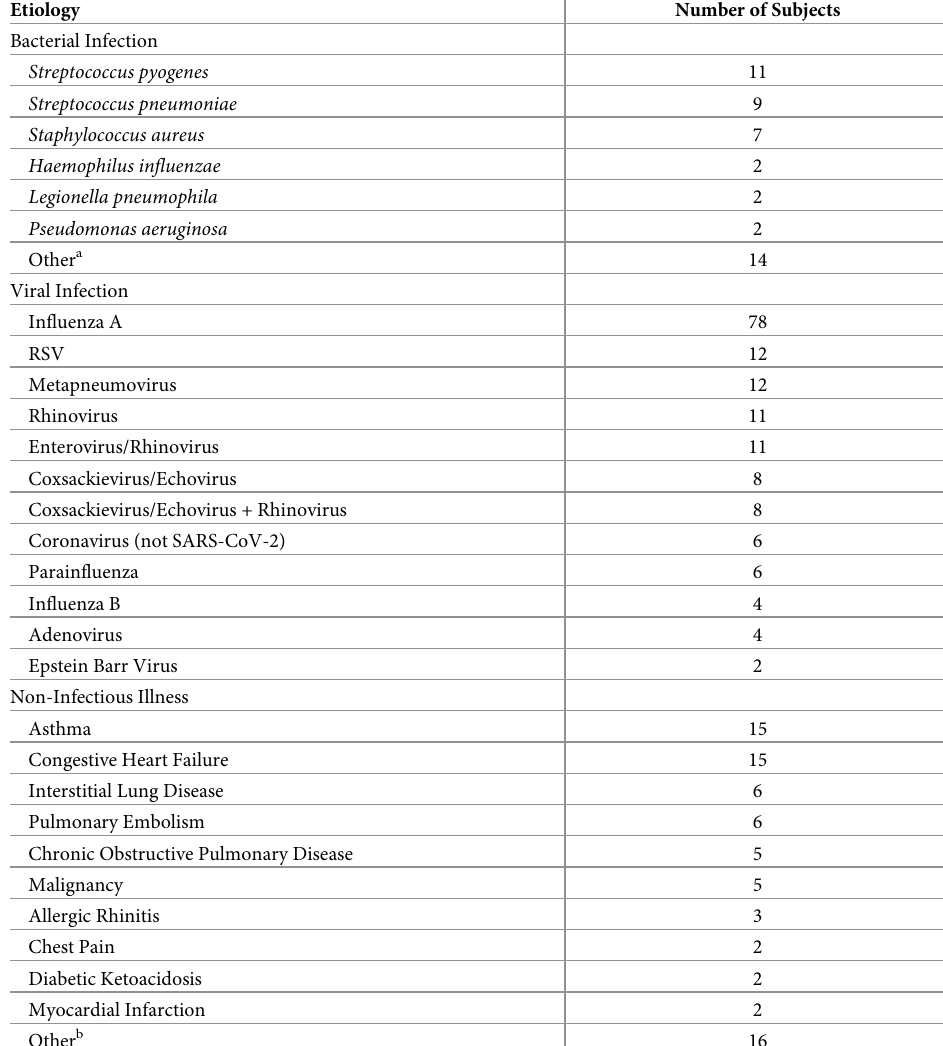
a Other bacterial etiologies included one instance of each of the following: Beta hemolytic Streptococcus (not Group A), Enterococcus faecalis , Escherichia coli , Klebsiella pneumoniae , Pasteurella multocida , Pseudomonas aeruginosa and A lcaligenes xylosoxidans , Staphylococcus aureus and Haemophilus influenzae , Staphylococcus aureus and Pseudomonas aeruginosa , Staphylococcus hominis , Streptococcus agalactiae and Coagulase negative Staphylococcus, Streptococcus anginosus , Streptococcus Group C, Streptococcus pneumoniae and Staphylococcus aureus , and Viridans Group Streptococcus. b Other non-infectious etiologies included one instance of each of the following: acute allograft rejection, acute respiratory distress syndrome, anaphylaxis, hemidiaphragm paralysis, hemoptysis, intoxication, malignant pleural effusion, migraine, nephrolithiasis, post-infectious cough, post-operative pain, post-operative vocal cord paralysis, pulmonary hypertension, subglottic papilloma, syncope,